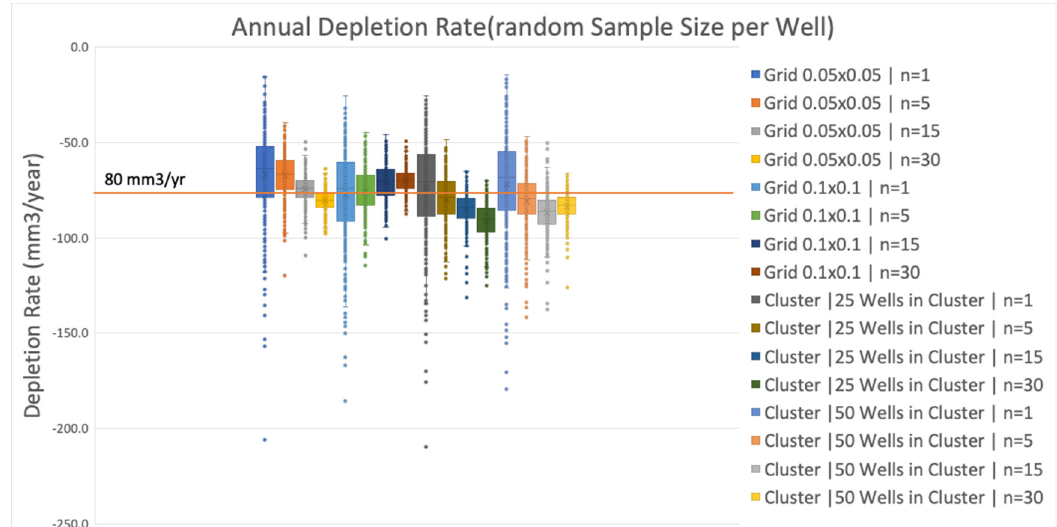
Figure 12. Summary of storage depletion rate calculations using 500 random data sets. These show that for a given scenario (group of four in the plot), as the number of random samples per well increases, the interquartile range of the ensemble decreases.